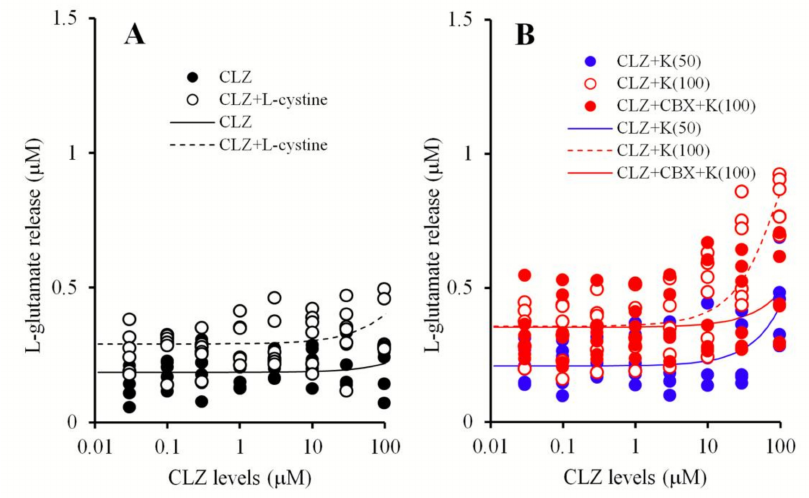
Figure 7. Concentration-dependent e ff ects of CLZ (0.03–100 µ M) on basal ganglia and 100 mM cystine-induced releases of l -glutamate from primary cultured astrocytes ( A ). Interaction between CLZ and CBX on 50 and 100 mM K + -evoked l -glutamate releases from primary cultured astrocytes ( B ). Ordinates: mean ± SD ( n = 6) of extracellular l -glutamate levels ( µ M). Abscissas: CLZ concentration ( µ M). Concentration-dependent e ff ects of CLZ on astroglial l -glutamate release was statistically analyzed using logistic regression